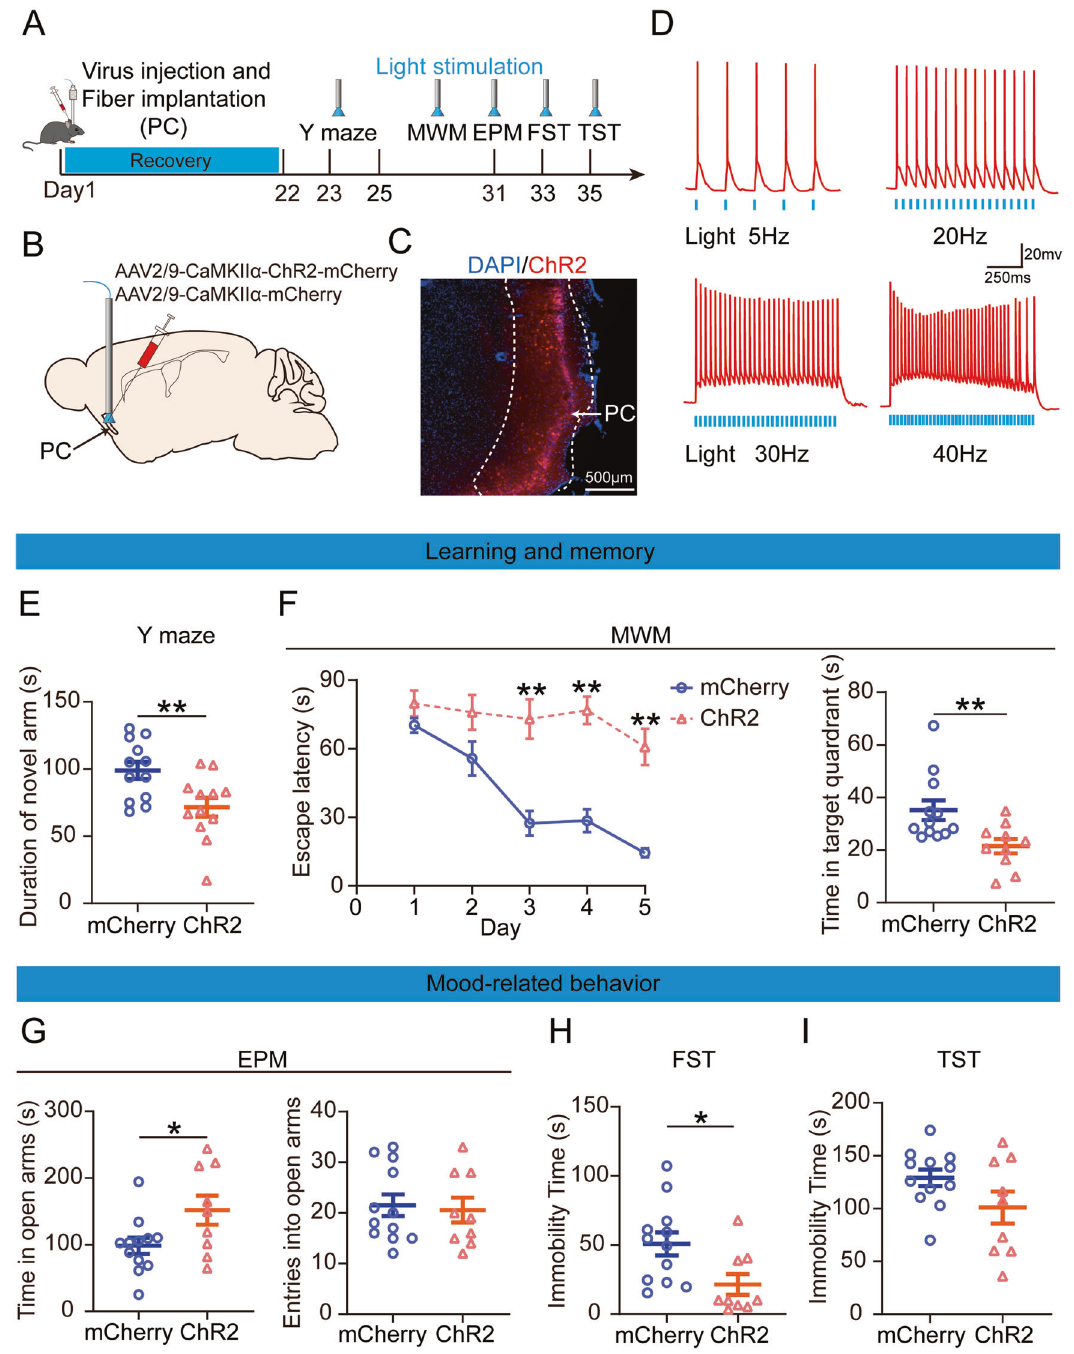
Fig. 4 Optogenetic activation of the piriform cortex (PC) excitability neurons decrease learning and memory but not mood-related behavior. A Experimental timeline for virus injection for investigating the behavioral impact of optogenetic activation. Blue light pulses at 30 Hz, 5 ms,10 mW. B , C Schematic of the sagittal section of the mouse brain shows ChR2 virus injection. D Representative recording of the action potential fi ring of CaMKII α expressing neurons in response to 5, 20, 30, and 40 Hz light photostimulation. E Quanti fi cation of the time spent in the novel arm by light photostimulation ( t 22 = 2.886, p = 0.009; Unpaired student ’ s t -test). mCherry, injection with mCherry- expressing viral vector in mice, n = 12; ChR2, injection with ChR2-expressing viral vector in mice, n = 12. F Escape latency ( F (1, 20) = 21.269, p < 0.001; Two-way repeated measures ANOVA) and the time spent in the target quadrant ( z = − 2.672, p = 0.008; Wilcoxon rank sum test). mCherry, n = 12; ChR2, n = 10. G Time in the open arms ( t 19 = − 2.291, p = 0.034; Unpaired student ’ s t -test) and open arm entries ( t 19 = 0.288, p = 0.777; Unpaired student ’ s t -test) during the elevated plus maze. mCherry, n = 12; ChR2, n = 9. H The immobility time in the forced swimming test ( z = − 2.417, p = 0.016; Wilcoxon rank sum test) and I tail suspension test ( t 19 = 1.768, p = 0.093; Unpaired student ’ s t -test). mCherry, n = 12; ChR2, n = 9. Data are presented as the mean ± SEM. * p < 0.05; * *p <